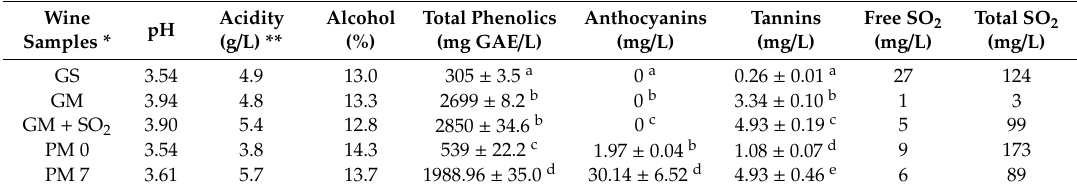
Table 1. Chemical composition of tested